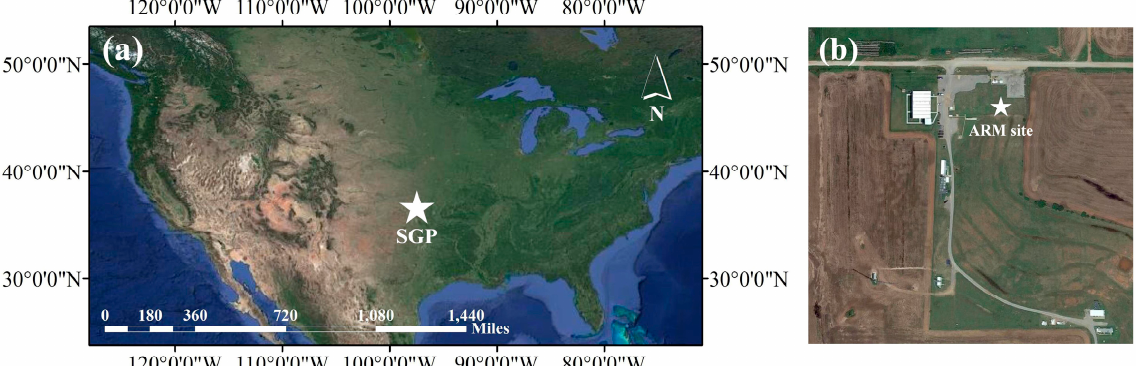
Figure 1. Study area of ( a ) Southern Great Plains, USA; and ( b ) Atmospheric Radiation Measurement site in the Southern Great Plains, USA.